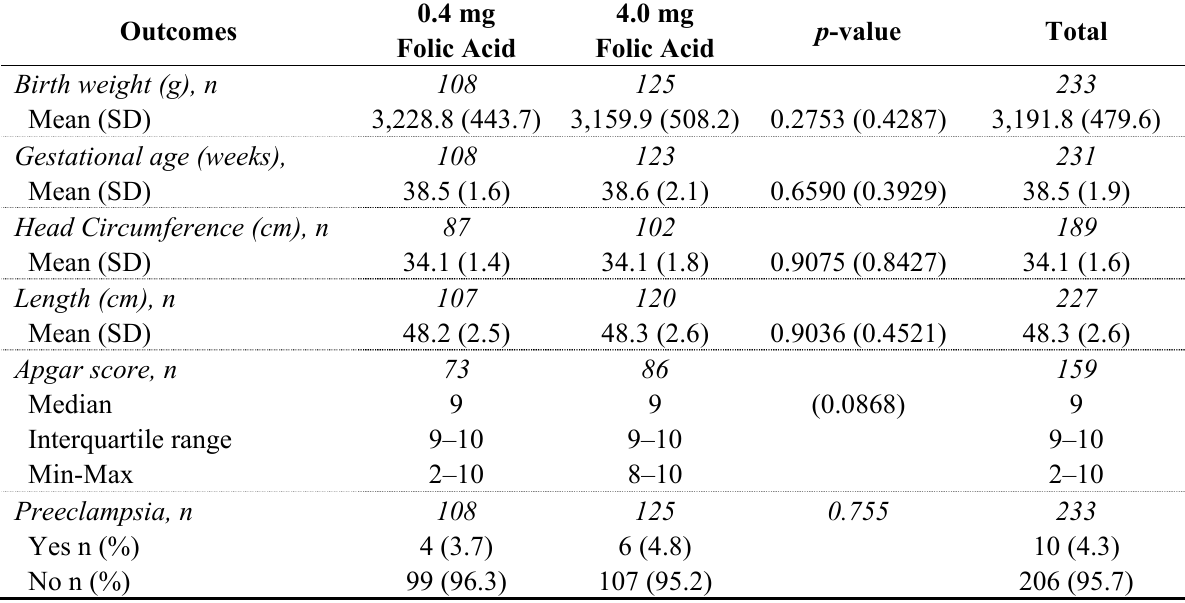
Table 5. Secondary outcomes by